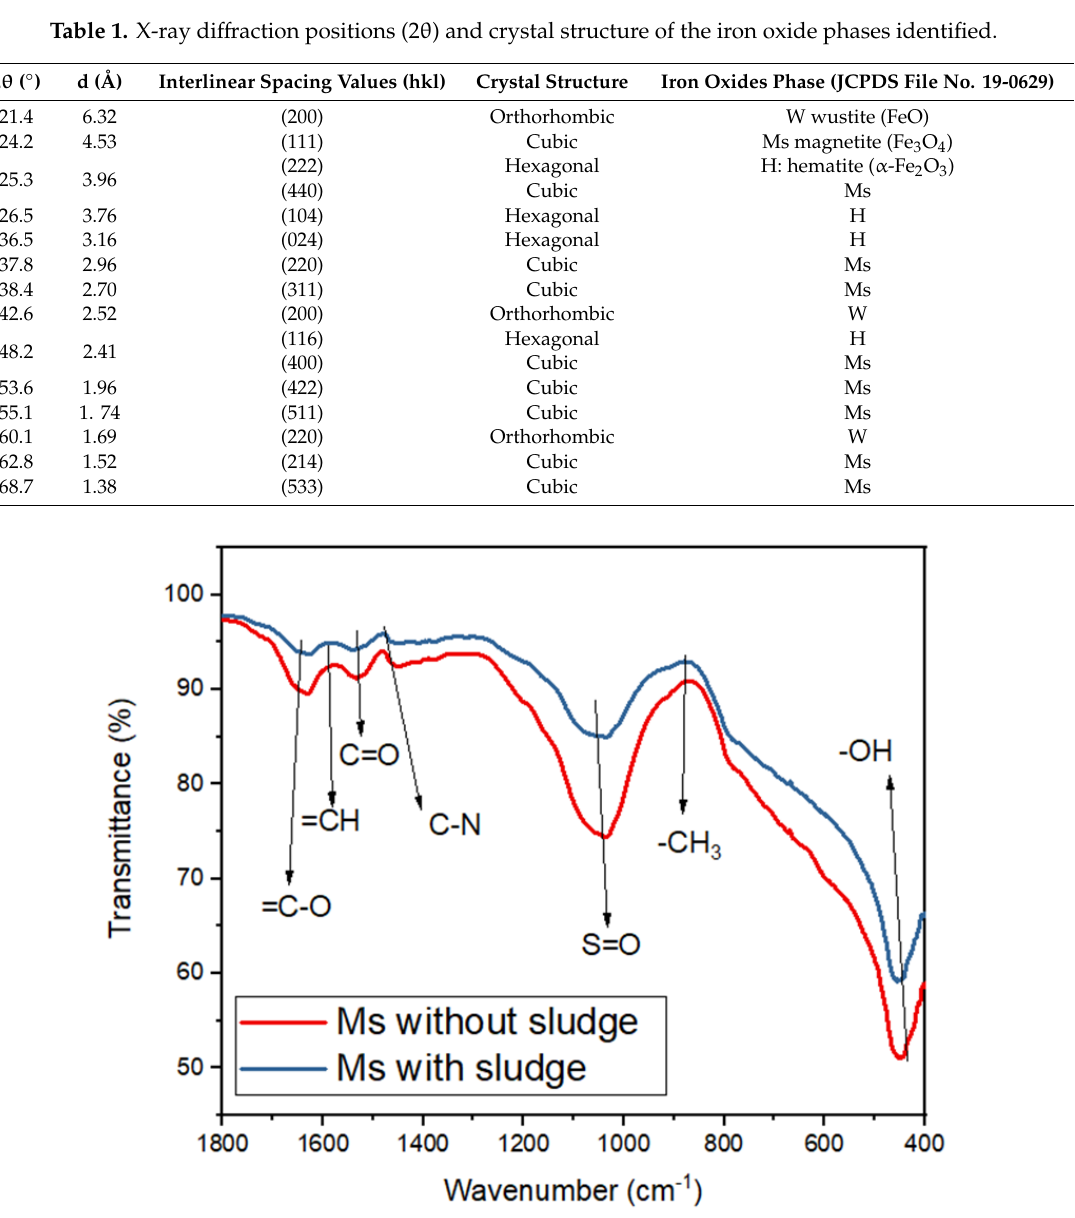
Figure 3. Fourier Transform Infrared (FTIR) spectra of Ms with and without sludge.